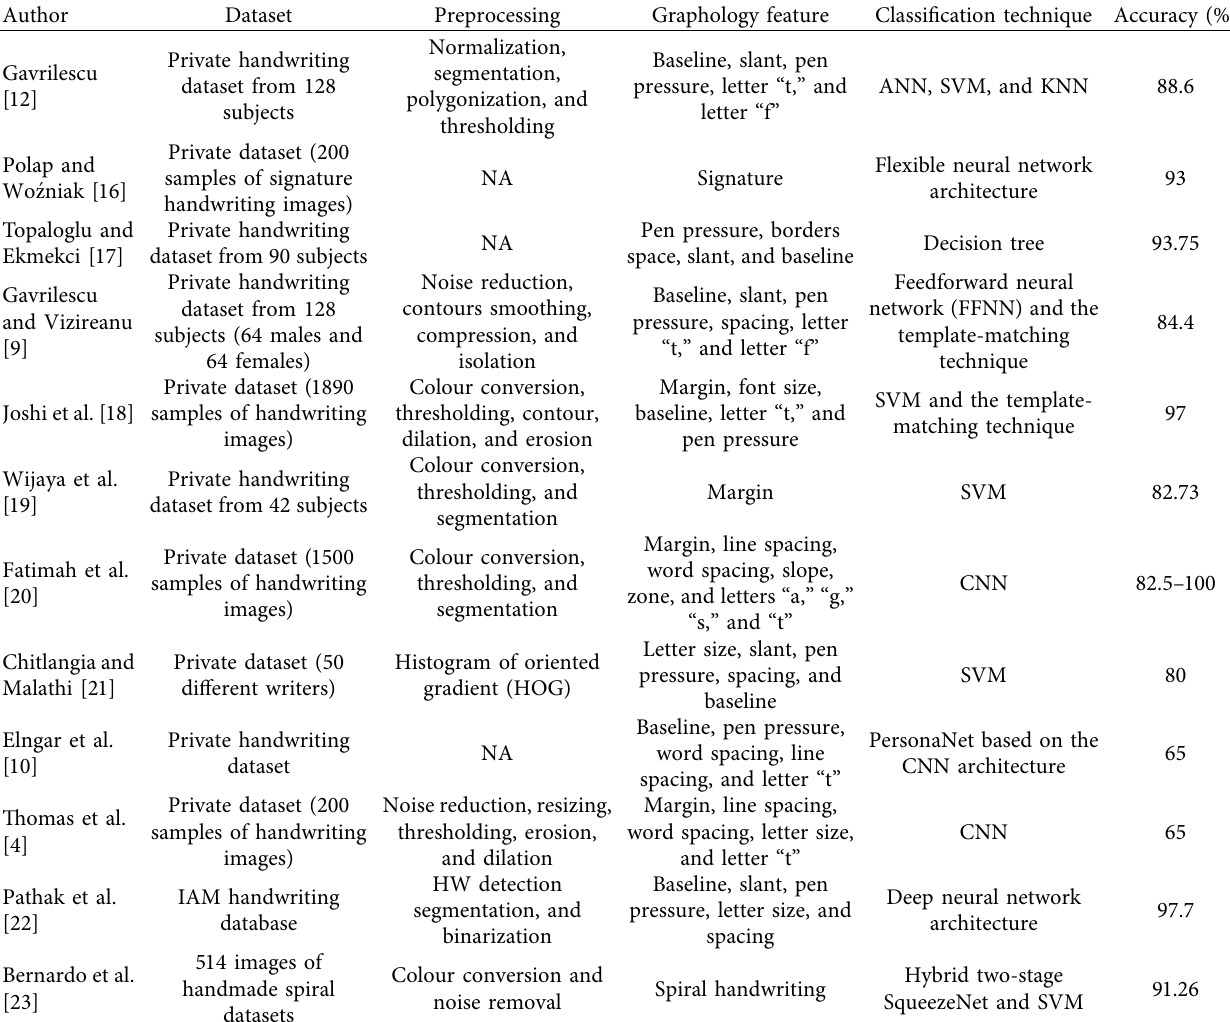
Table 1: Literature survey